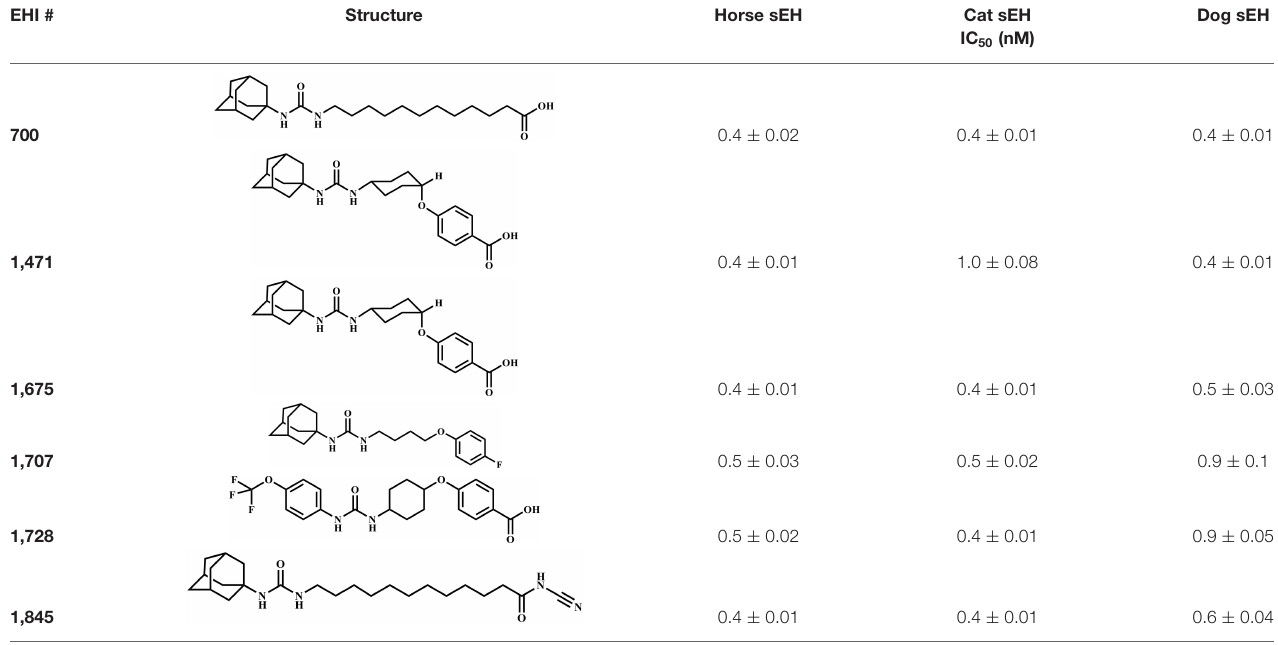
TABLE 3 | Inhibition potency of selected compounds for the horse, cat, and dog sEH. EHI #